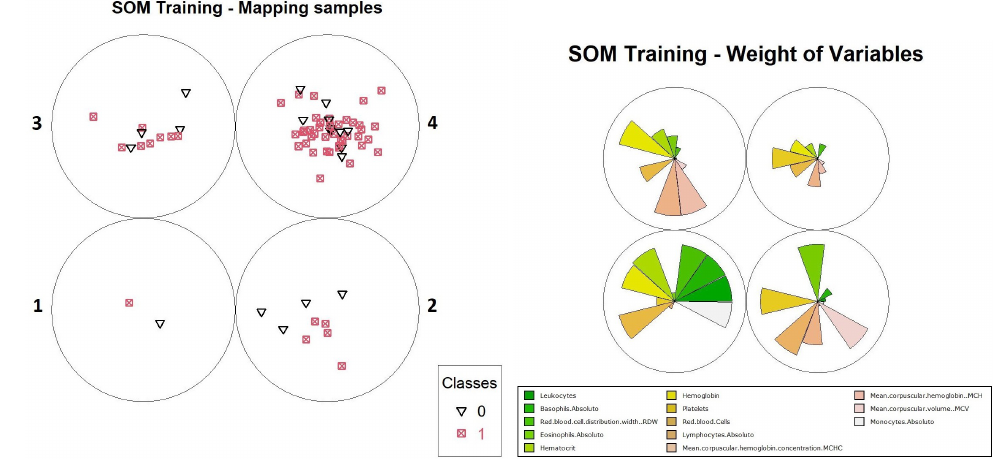
Figure 21. Distribution of objects and weights per neuron—level 3 TESSOM